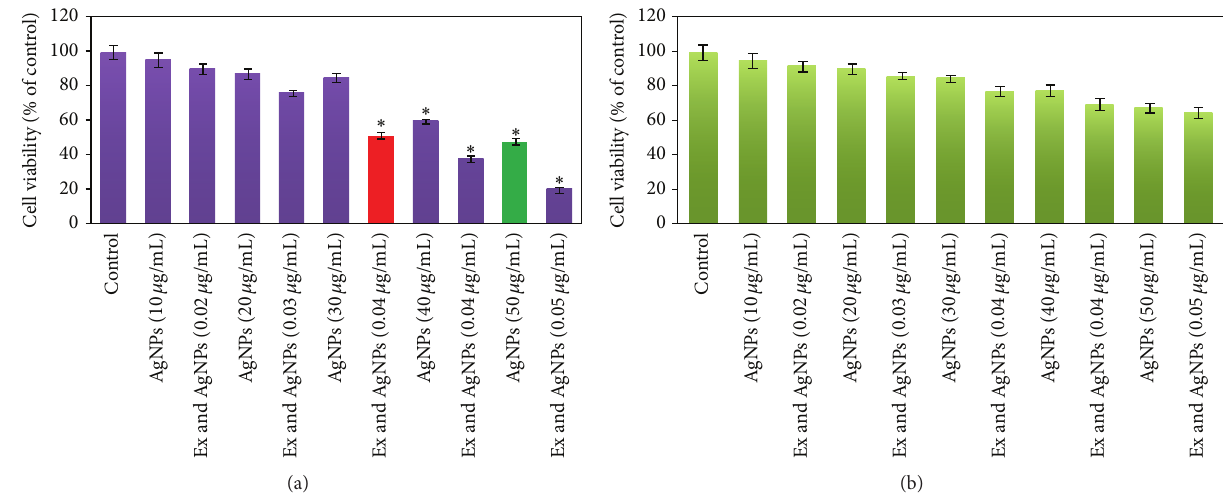
Figure 8: MTT assay results. (a) Cytotoxic effects of dispersed AgNPs in the Jaft extract and AgNPs on cancer cell line (MCF-7) and (b) cytotoxic effects of dispersed AgNPs in the Jaft extract and AgNPs on normal cell line (human blood mononuclear cells). Data are calculated as mean ± SD of three experiments. AgNPs: dispersed AgNPs in purified water, Ex & AgNPs: dispersed AgNPs in the Jaft extract, control: untreated cell line. Percentage of cytotoxicity is expressed relative to untreated controls ( ∗ significant 𝑃 < 0.05